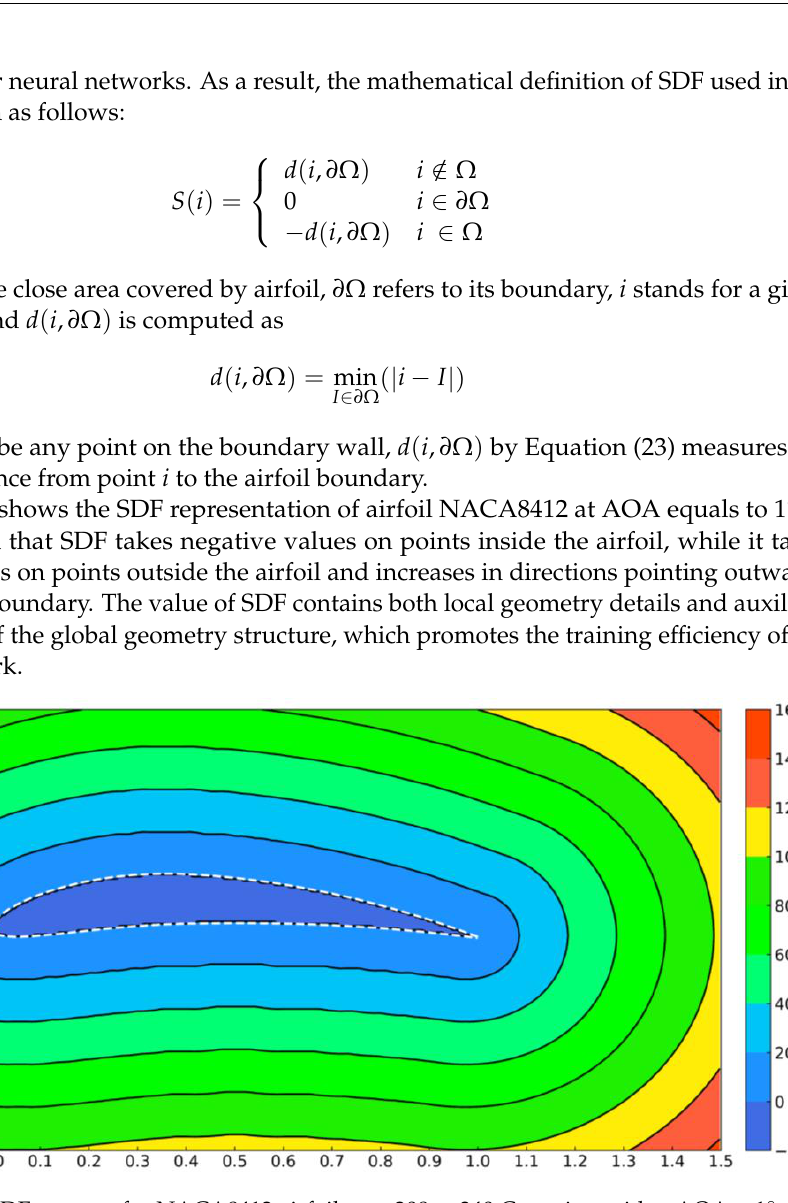
Figure 7. The SDF contour for NACA8412 airfoil on a 208 × 340 Cartesian grid at AOA = 1°. The airfoil boundary is the dashed line in white color.